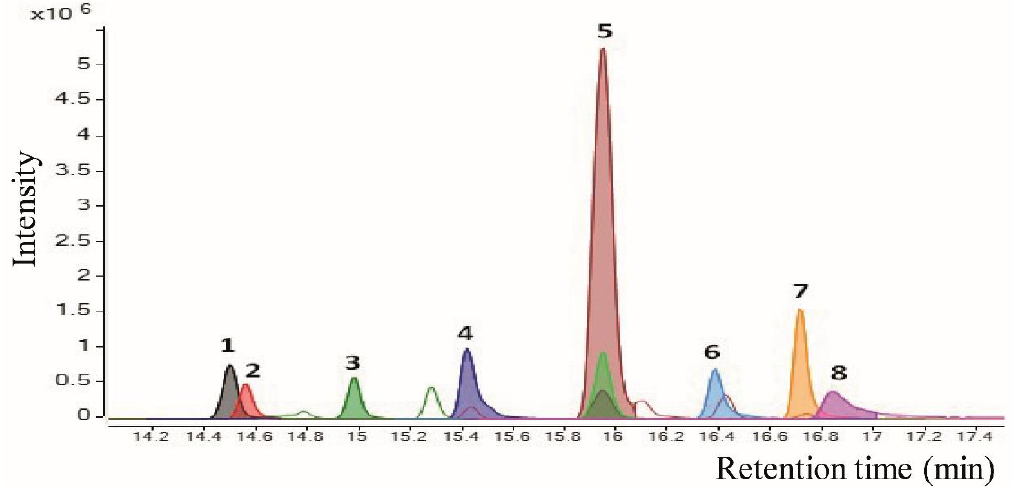
Figure 9. Overlay of the extracted ion chromatograms (EICs) for compounds present in the extract of the purest fraction. The enlargements of a part of the chromatogram are shown from 14.0 to 17.5 min.